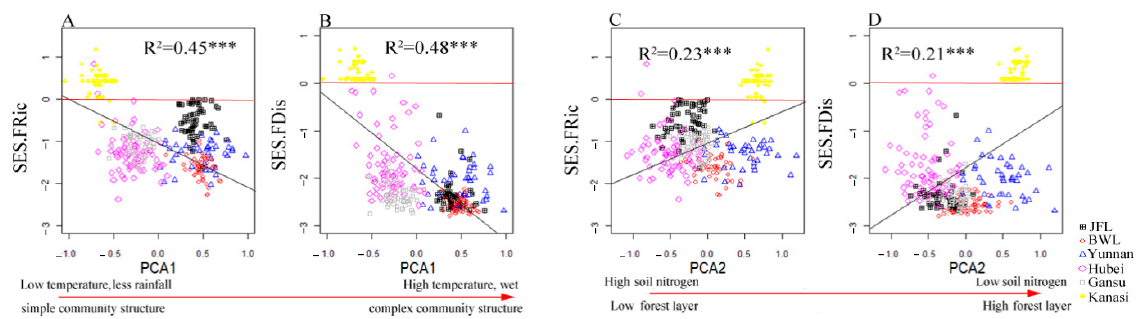
Figure 2. The relationships between functional diversity, SES.FRic ( A , C ) and SES.FDis ( B , D ), and compound habitat gradients, PC1 ( A , B ) and PC2 ( C , D ), of forest vegetation communities in China. Different color–marker combinations represent each forest plot. The abbreviations for each variable are listed in Table 1. Significance values: ***, p < 0.001.